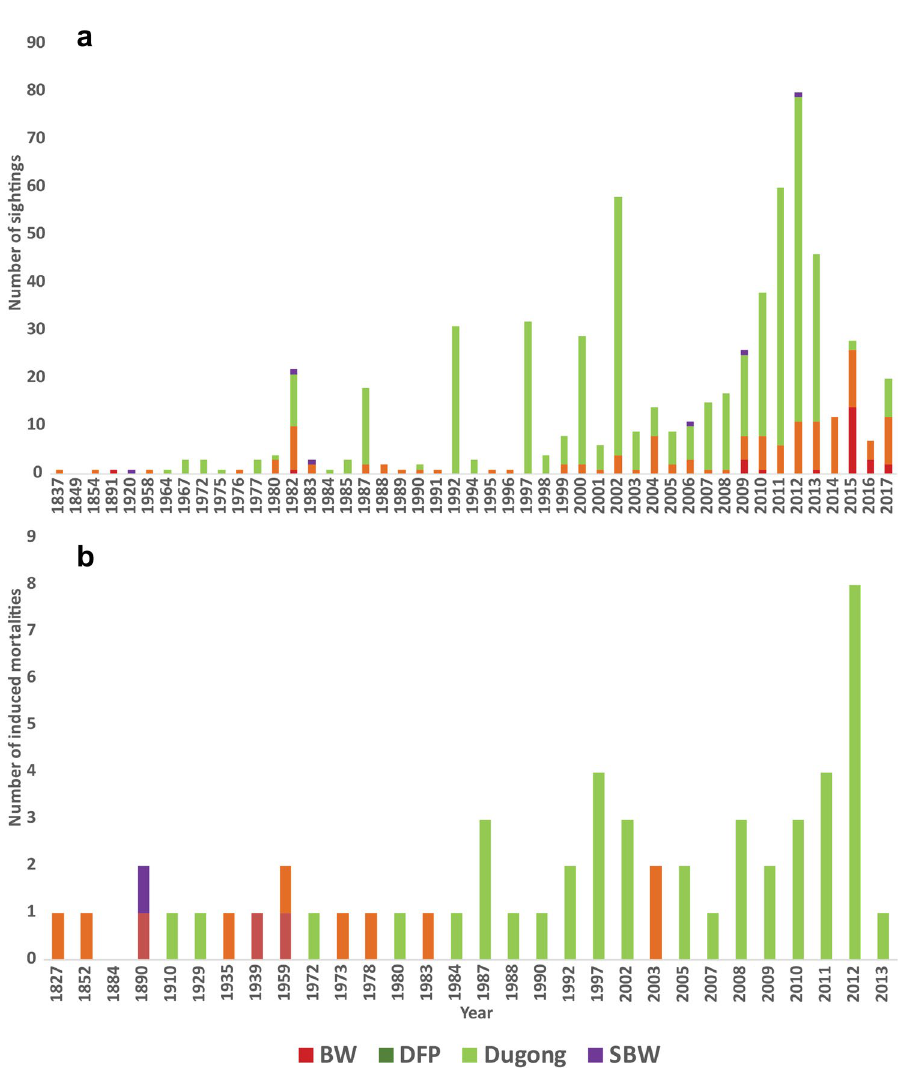
Figure 2. Marine mammal records obtained every year from the data compiled between years 1748–2017 along Indian coastline given as cumulative numbers for each group i.e., baleen whales (BW), dolphins and finless porpoise (DFP), sperm and beaked whales (SBW) and dugongs, as color-coded stacked bars, where ( a ) sighting records—records where live animals were sighted ( b ) induced mortalities—records where animals were reported hunted or killed or were driven ashore, ( c ) incidental mortalities—records where animals were found dead after entanglement in fishing nets or being struck by vessels and ( d ) stranding records—records where dead or live animals were found washed ashore, or floating near shore or stranded alive and were attempted for